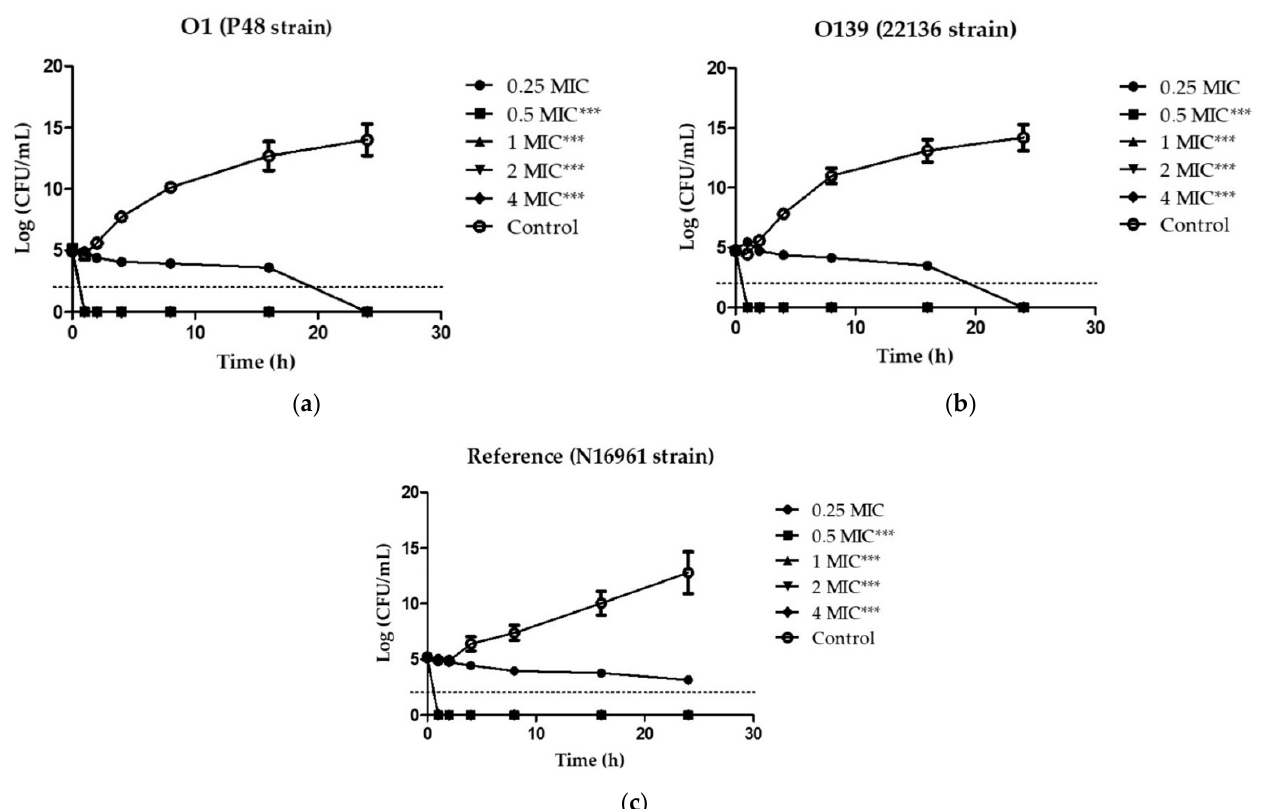
Figure 1. Effect of EGCG on the viability of V. cholerae . Time-kill kinetics of V. cholerae O1 ( a ), O139 ( b ) and reference strain ( c ) at concentrations of 0.25× to 4× MIC against V. cholerae were investigated over a 24 h incubation period at 37 °C. The MIC for EGCG were 125 µg/mL for all strains. MHB was used as the control instead of compound. Samples were taken at 1, 2, 4, 8, 16, and 24 h, to determine viable bacterial numbers. The bactericidal level is indicated by the dashed lines. Significant differ- ences compared to untreated controls at 1 h are indicated by asterisks: *** p <